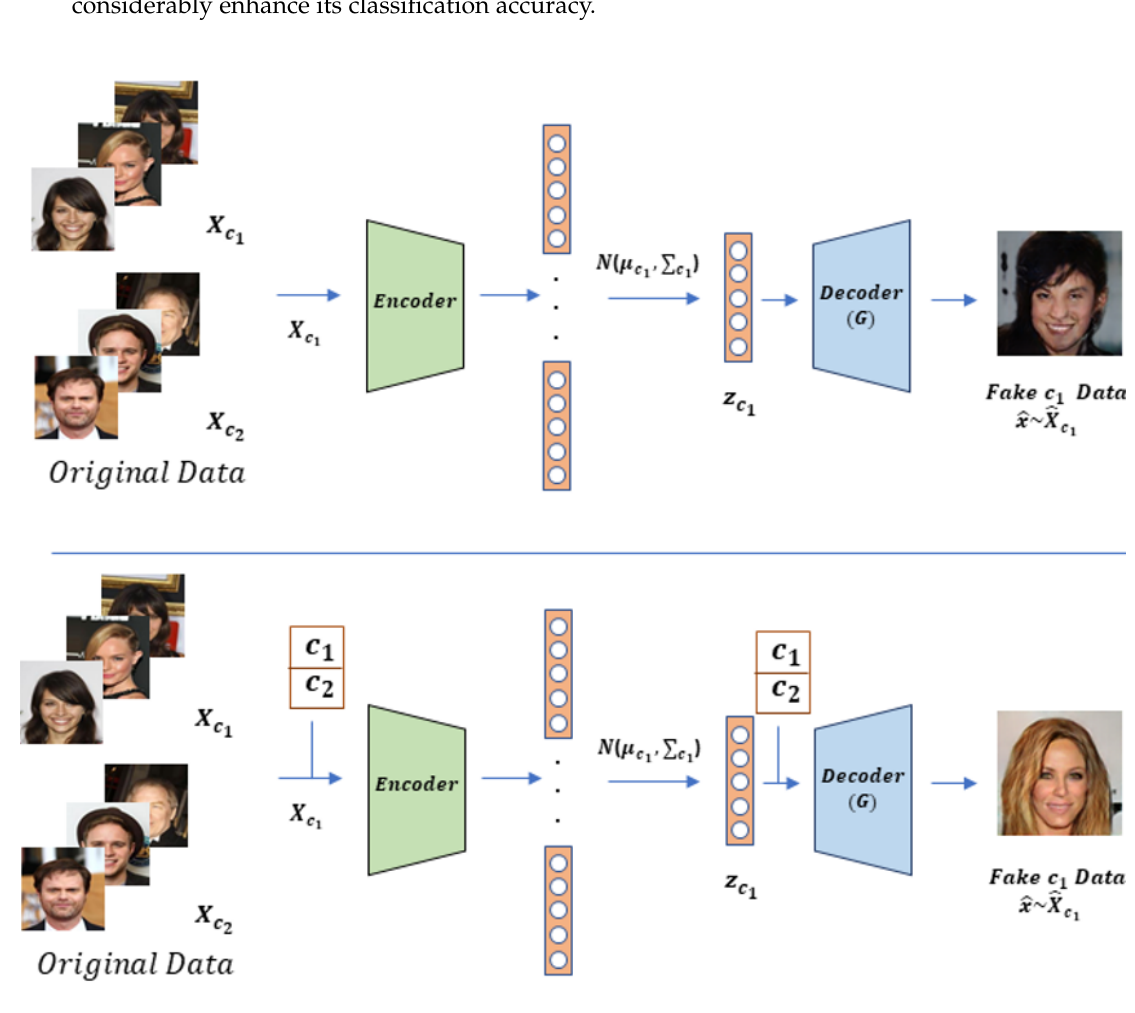
Figure 2. Conceptual comparison between BAGAN generator and the proposed GANDA